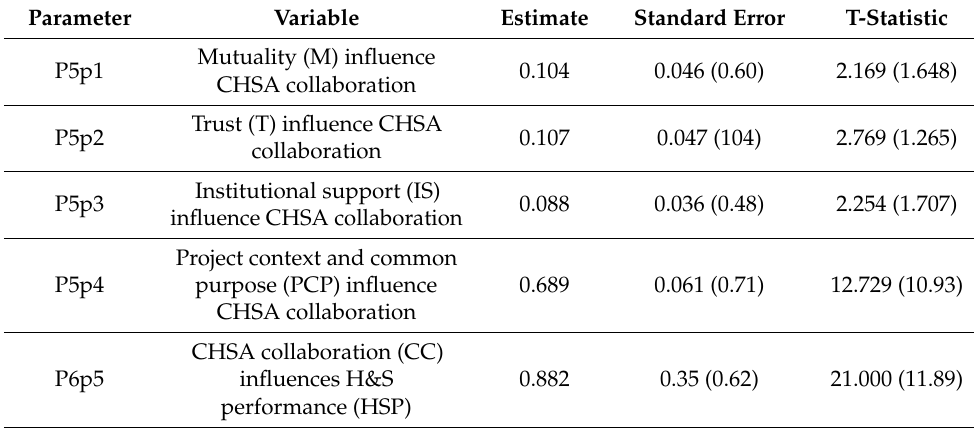
Table 13. Path analysis parameter estimates.